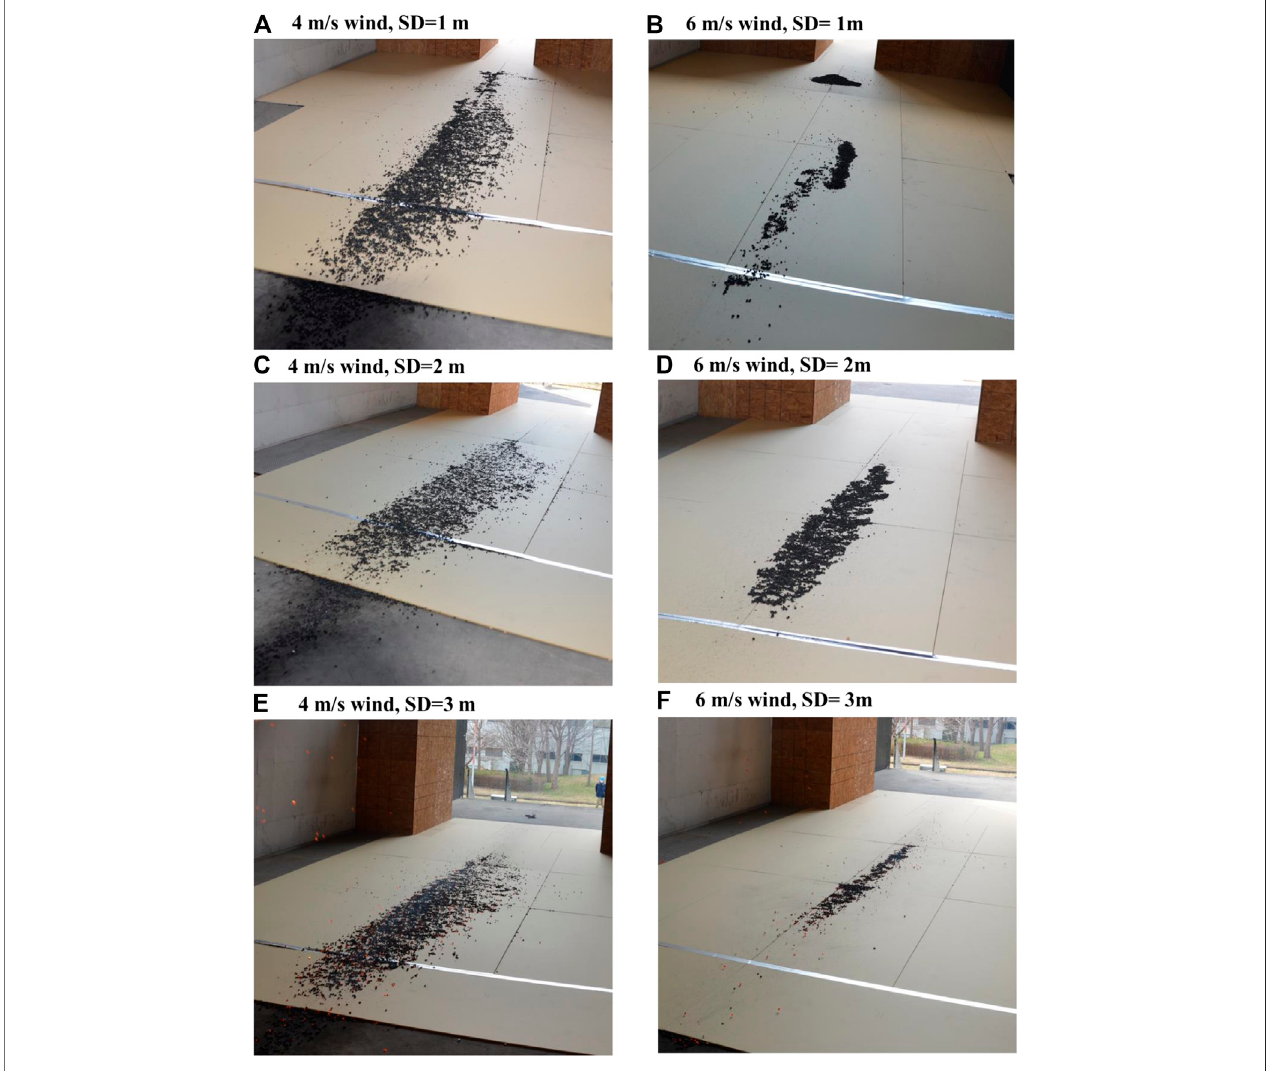
FIGURE 5 | Firebrand Accumulation pattern under different wind speeds and SD (A) 4 m s − 1 and SD = 1 m (B) 6 m s − 1 and SD = 1 m, (C) 4 m s − 1 and SD = 2 m, (D) 6 m s − 1 and SD = 2 m, (E) 4 m s − 1 and SD = 3 mand (F) 6 m s − 1 and SD = 3 m. Images under 8and 10 m s − 1 are notprovided asaccumulation wasnot observed.